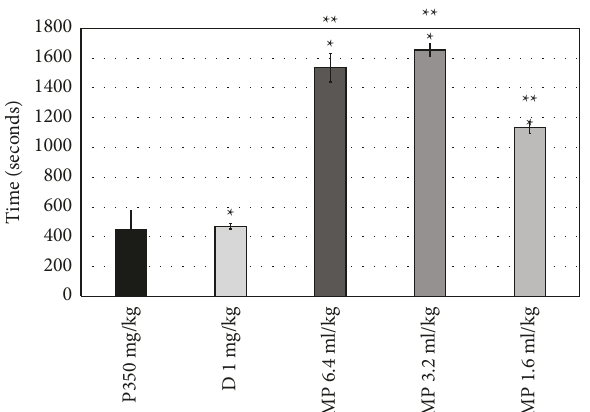
Figure 3: Effects of MPO (6.4, 3.2, and 1.6ml/kg) on latency time of death in the pilocarpine-induced epilepsy model in mice, ∗ P < 0 . 5 when contrasted to the P350 group, ∗∗ P < 0 . 5 when contrasted to the D group. P: pilocarpine, D: diazepam, MP: Mentha piperita L . oil.